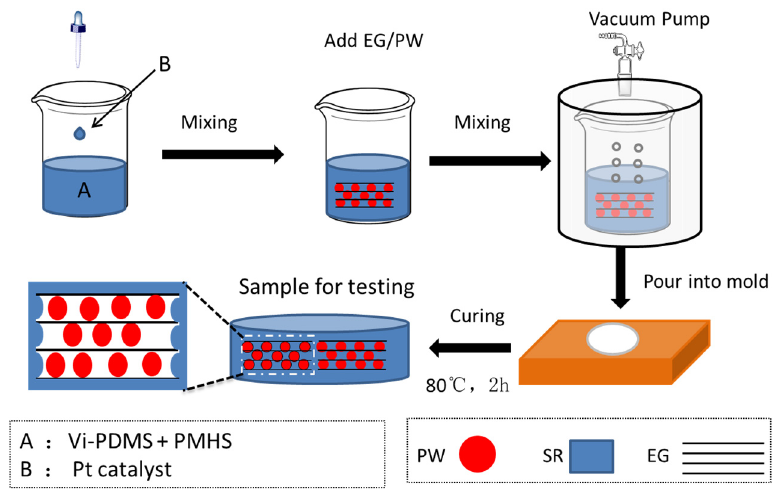
Figure 1. Schematic illustration of the preparation process of expanded graphite (EG)/paraffin wax (PW)/silicone rubber (SR) composites.